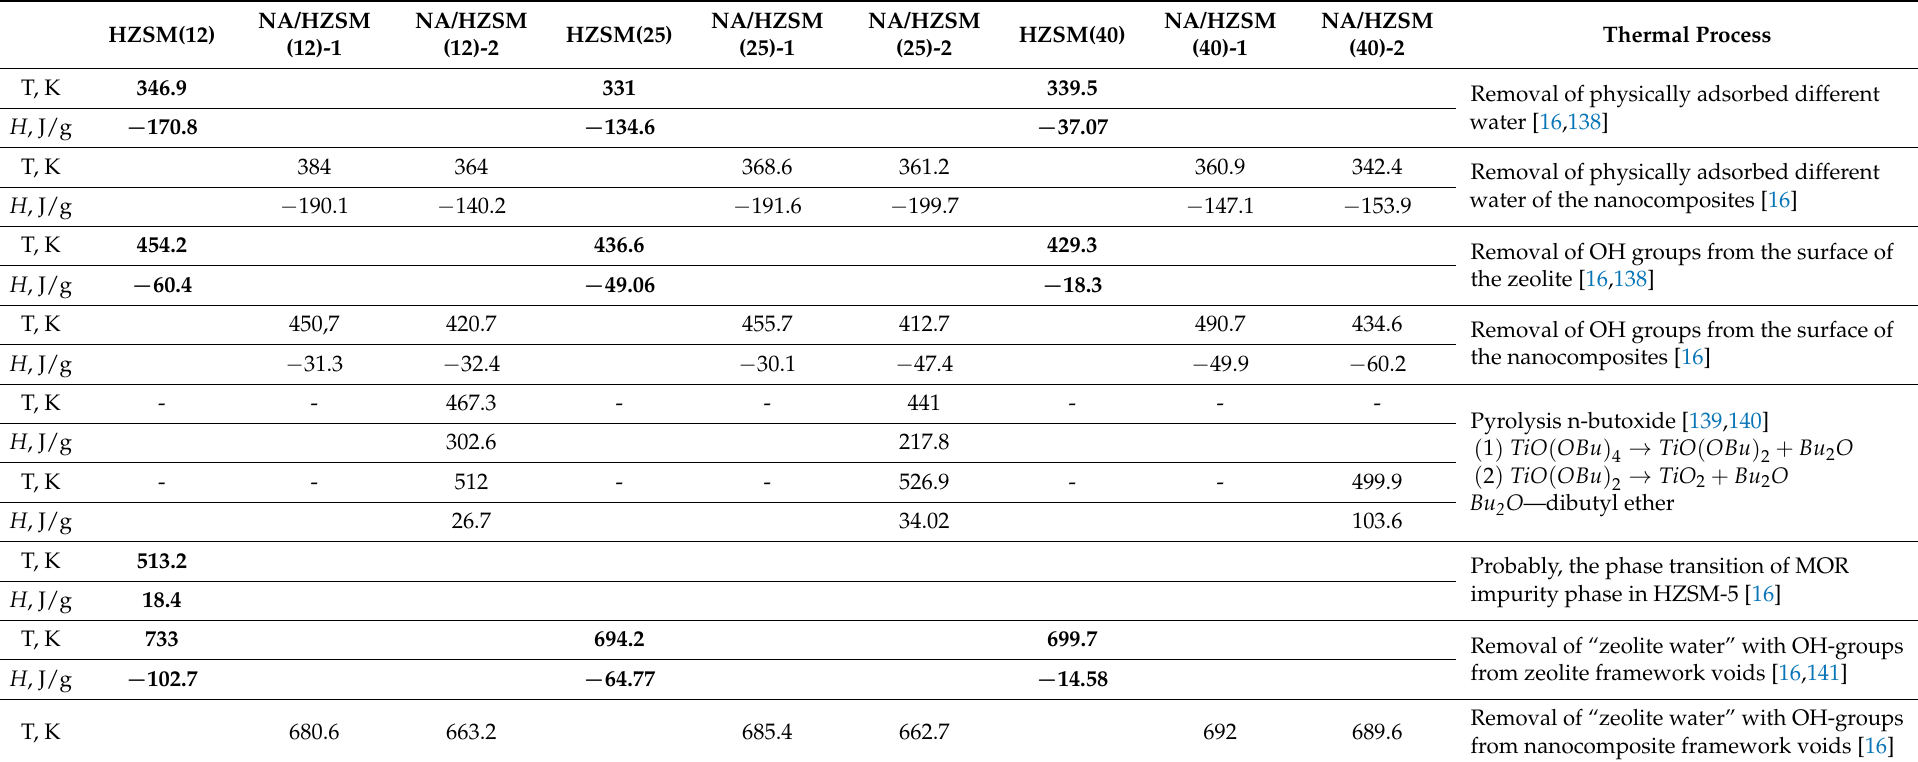
Table 4. Correspondence of peaks (T, K) in HZSM and NA/HZSM-1,2 DSC thermograms to possible thermal